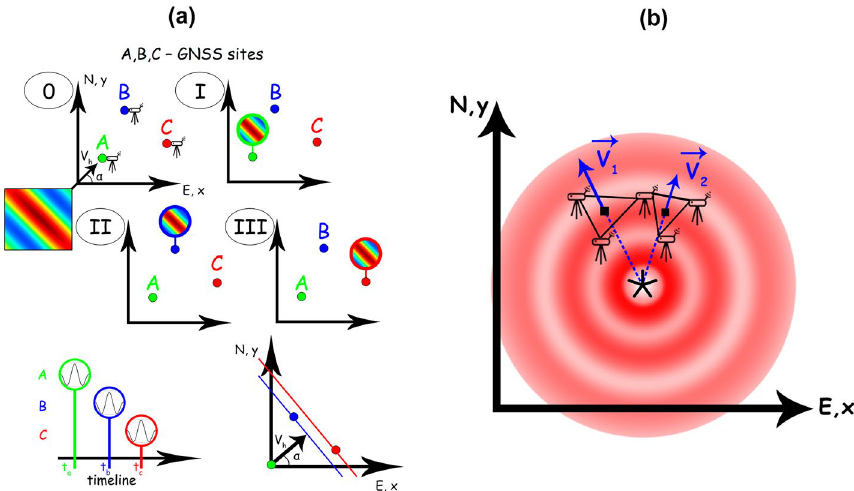
Figure 4. ( a ) Explanation of D1 technique . A, B, C—GNSS stations that are used to determine the CSID parameters: horizontal velocity ( v h ) and azimuth ( α ). 0, I, II, III mark the moments of time when the perturbation approaches the detection triangle (0) and when the perturbation is detected at points A, B, and C, respectively. The wavefront is considered to be plain; ( b ) Ionospheric localization of CTIDs based on the known location and values of two velocity vectors V 1 and V 2 as determined by using the